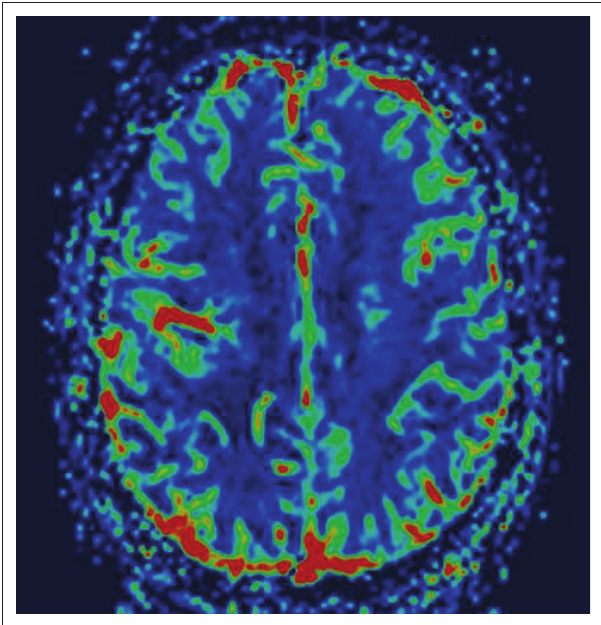
FIGURE 6: Axial rCBV MR perfusion image.